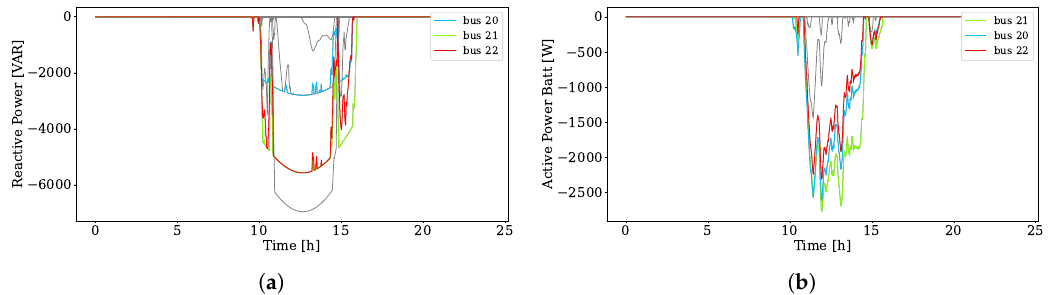
Figure 11. ESS power and DG reactive power with prioritized use of the DG over the ESS. ( a ) Reactive power generated by PVs. ( b ) Active power injected by ESS.